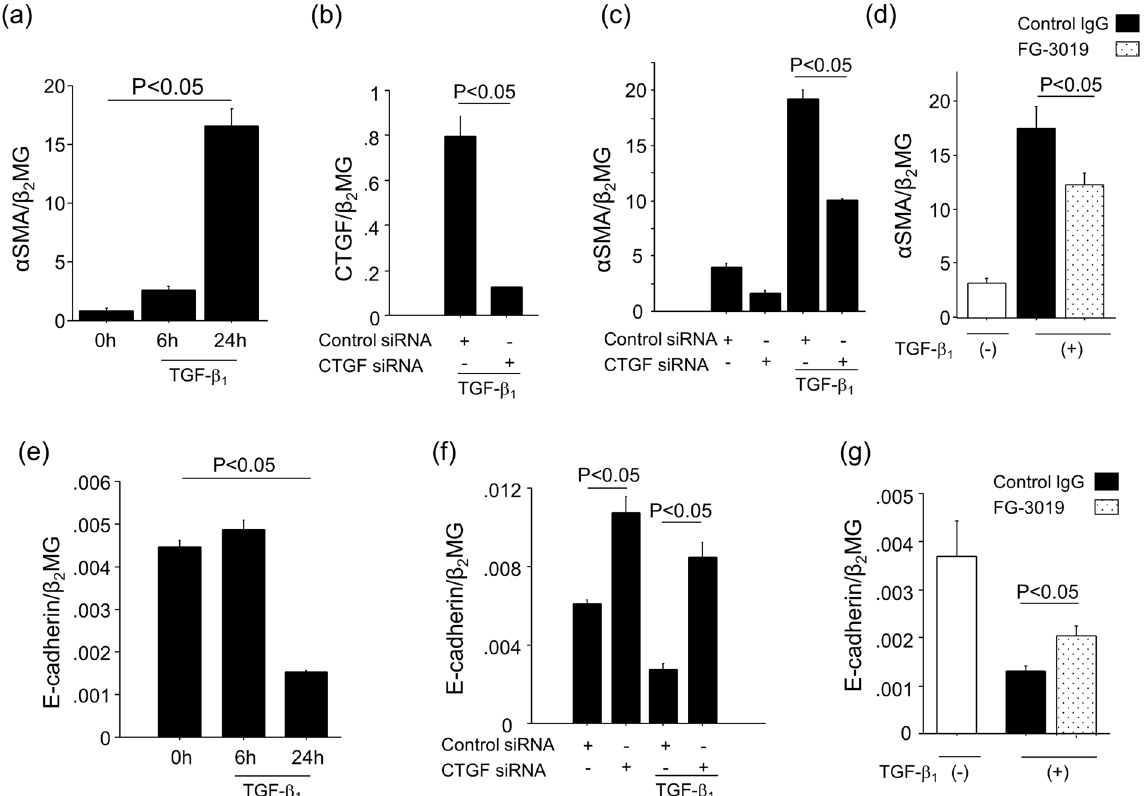
Figure 7. Inhibition of CTGF suppressed TGF- β 1 -induced MMT in PMCs. ( a ) α SMA expression upon stimulation of PMCs with 5 ng/ml TGF- β 1 . (n = 3 cell preparations/group). ( b ) Validation of siRNA inhibition of CTGF. PMCs were transfected with CTGF siRNA or control siRNA, and CTGF expression in response to TGF- β 1 was determined 2 hours after the stimulation. (n = 3 cell preparations/group). ( c ) The effect of CTGF knockdown on TGF- β 1 -induced α SMA expression. PMCs were transfected with control siRNA or CTGF siRNA, and then stimulated with TGF- β 1 (5 ng/ml for 24 hrs). (n = 3 cell preparations/group). ( d ) Effect of CTGF inhibition on TGF- β 1 -induced α SMA expression. PMCs were preincubated with FG-3019 (10 μ g/ml) or control IgG (10 μ g/ml) for 1 h, and then stimulated with TGF- β 1 (5 ng/ml for 24 hrs). (n = 6 cell preparations/ group). ( e ) E-cadherin expression upon stimulation of PMCs with 5 ng/ml TGF- β 1 . (n = 3 cell preparations/ group). ( f ) The effect of CTGF knockdown on TGF- β 1 -induced E-cadherin expression. PMCs were transfected with control siRNA or CTGF siRNA, and then stimulated with TGF- β 1 (5 ng/ml for 24 hrs). (n = 3 cell preparations/group). ( g ) Effect of CTGF inhibition on TGF- β 1 -induced E-cadherin expression. PMCs were preincubated with FG-3019 (20 μ g/ml) or control IgG (20 μ g/ml) for 1 h, and then stimulated with TGF- β 1 (5 ng/ml for 24 hrs). (n = 3 cell preparations/group). All data are expressed as mean ±